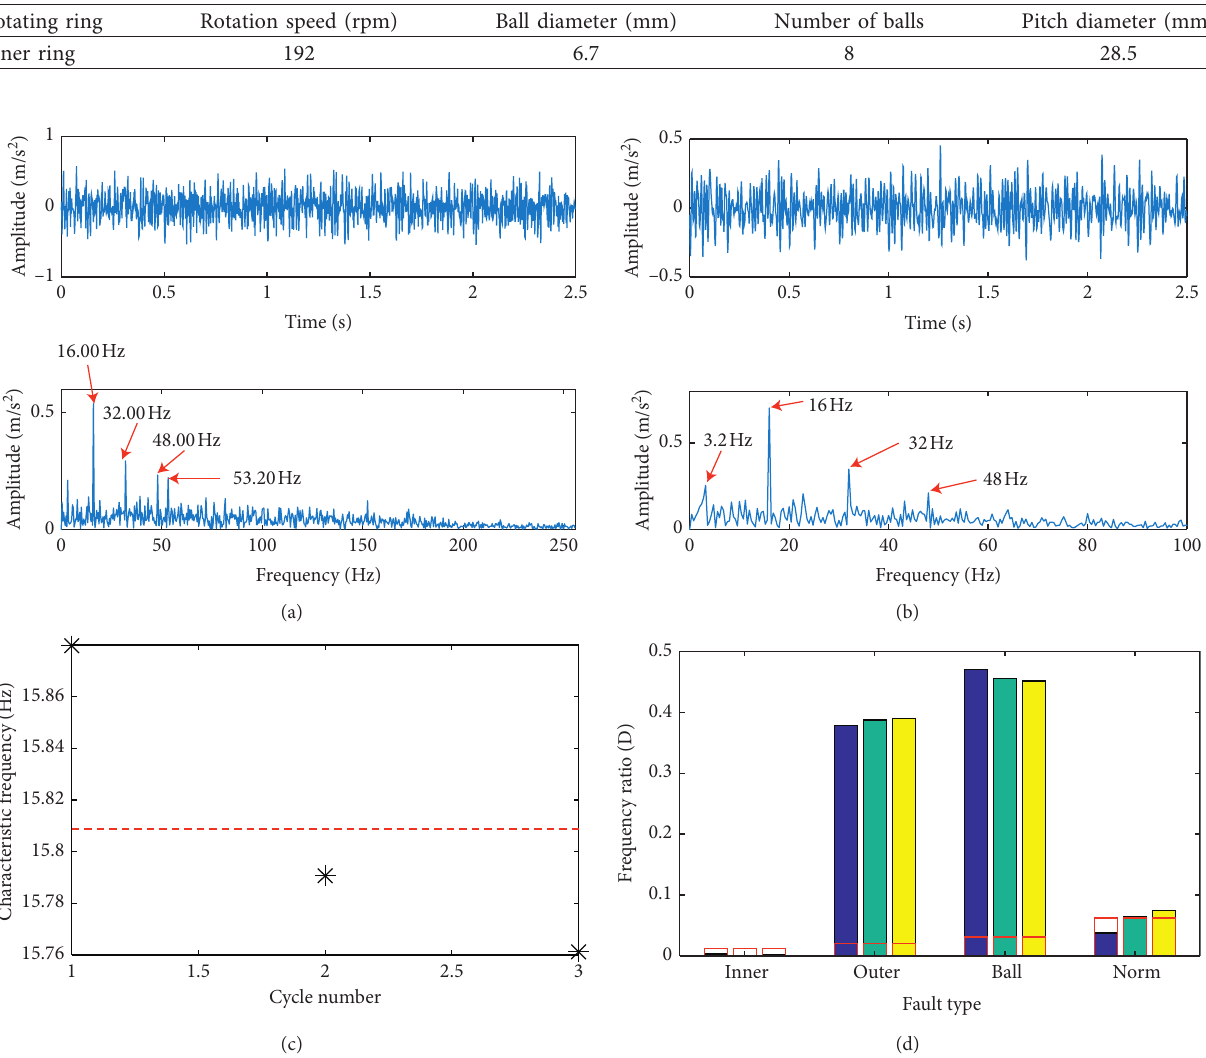
Figure 13: Different fault types of rolling bearing: (a) inner ring fault; (b) outer ring fault; (c) rolling element fault. Table 2: The parameters of the rolling bearing.